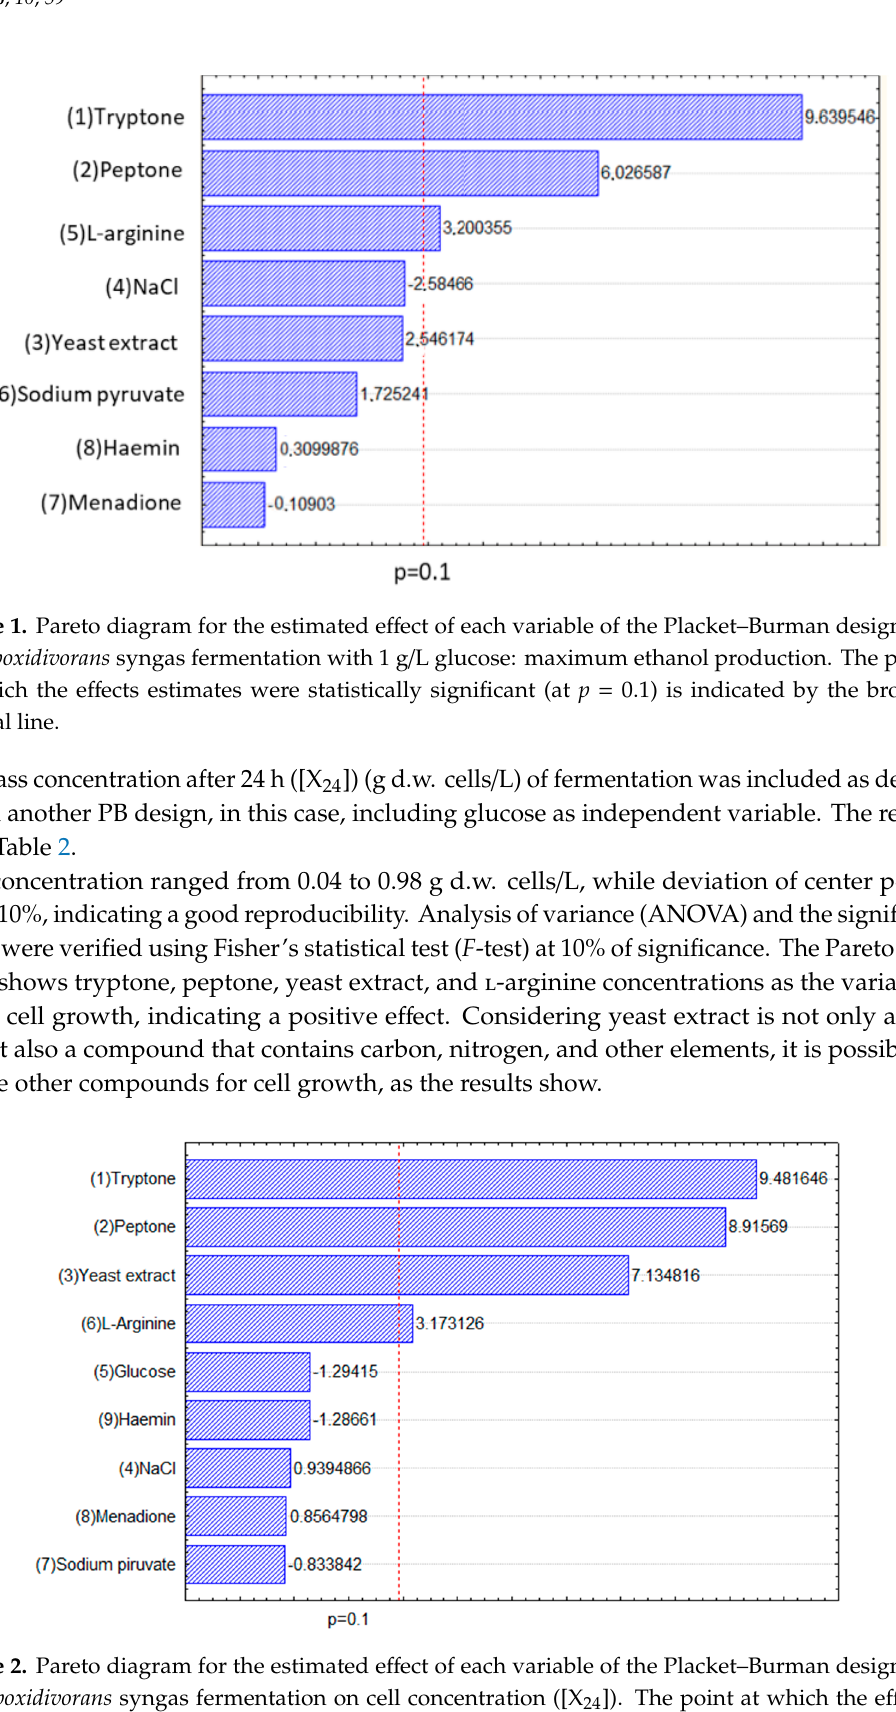
Figure 2. Pareto diagram for the estimated effect of each variable of the Placket–Burman design for C. carboxidivorans syngas fermentation on cell concentration ([X 24 ]). The point at which the effects estimates were statistically significant (at p = 0.1) is indicated by the broken vertical line.